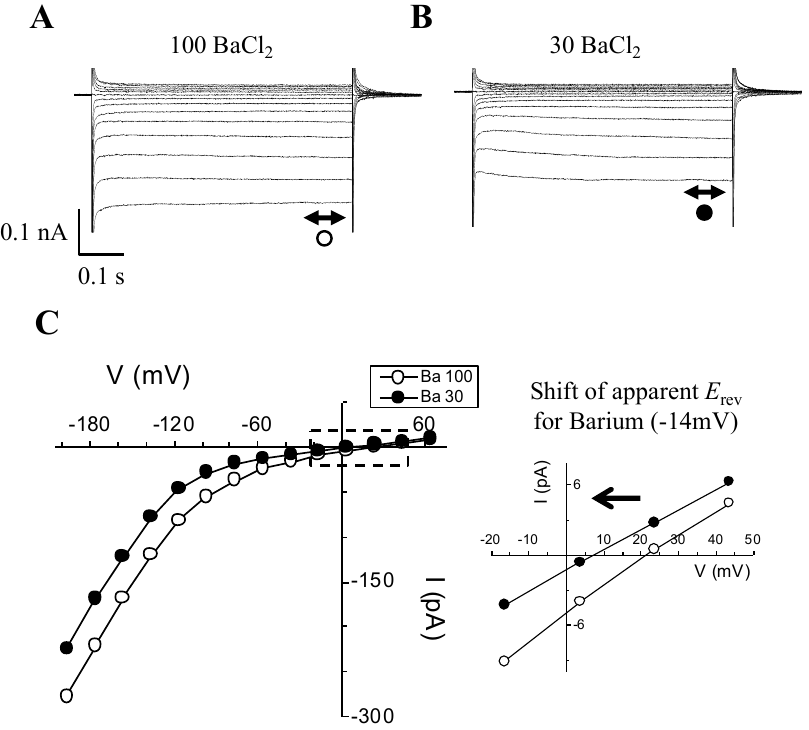
Figure 2. Decreasing [Ba 2 + ] o from 100 to 30 mM not only decreases the hyperpolarization-activated I Ba but also shifts its apparent reversal potential ( E rev ) ( ∼− 14 mV). ( A , B ) Typical current traces of hyperpolarization-activated I Ba recorded from the same V. faba guard cell in either 100 ( A ) or 30 mM ( B ) [Ba 2 + ] o . Scale bars are shown below the current traces. ( C ) Corresponding I-V plots of I Ba in 100 and 30 mM [Ba 2 + ] o taken from the current traces shown in ( A ) and ( B ). Inset: Magnified I-V plot from the area shown as a dashed box in ( C ). The inset shows the amount (in mV) and the direction (arrow) of the shift in the apparent E rev when the bath perfusion was switched from 100 to 30 mM Ba 2 + .